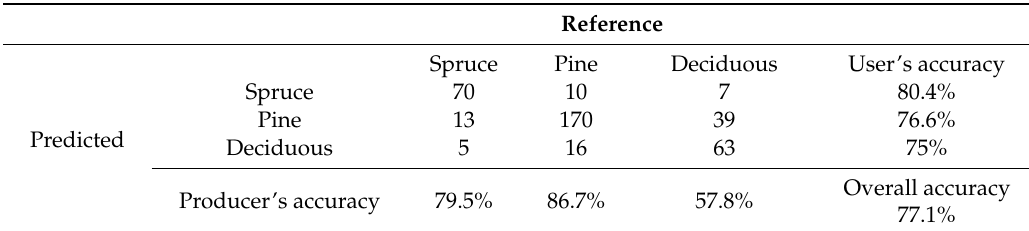
Table 2. Confusion matrix of tree species